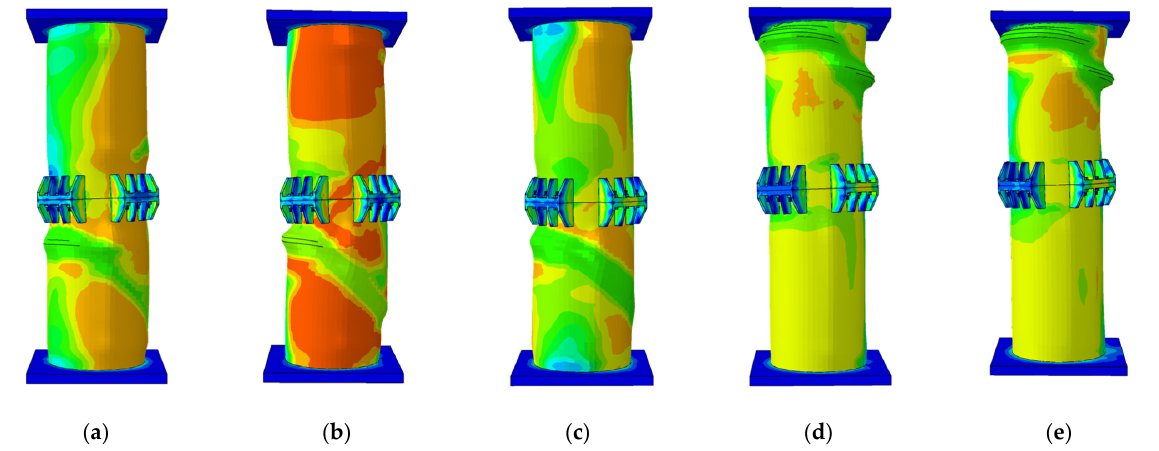
Figure 27. Simulation failure modes of BWCFST short columns with spherical-cap gap of different χ : ( a ) χ = 0%; ( b ) χ = 2.3%; ( c ) χ = 4.6%; ( d ) χ = 6.9%; ( e ) χ = 9.2%.